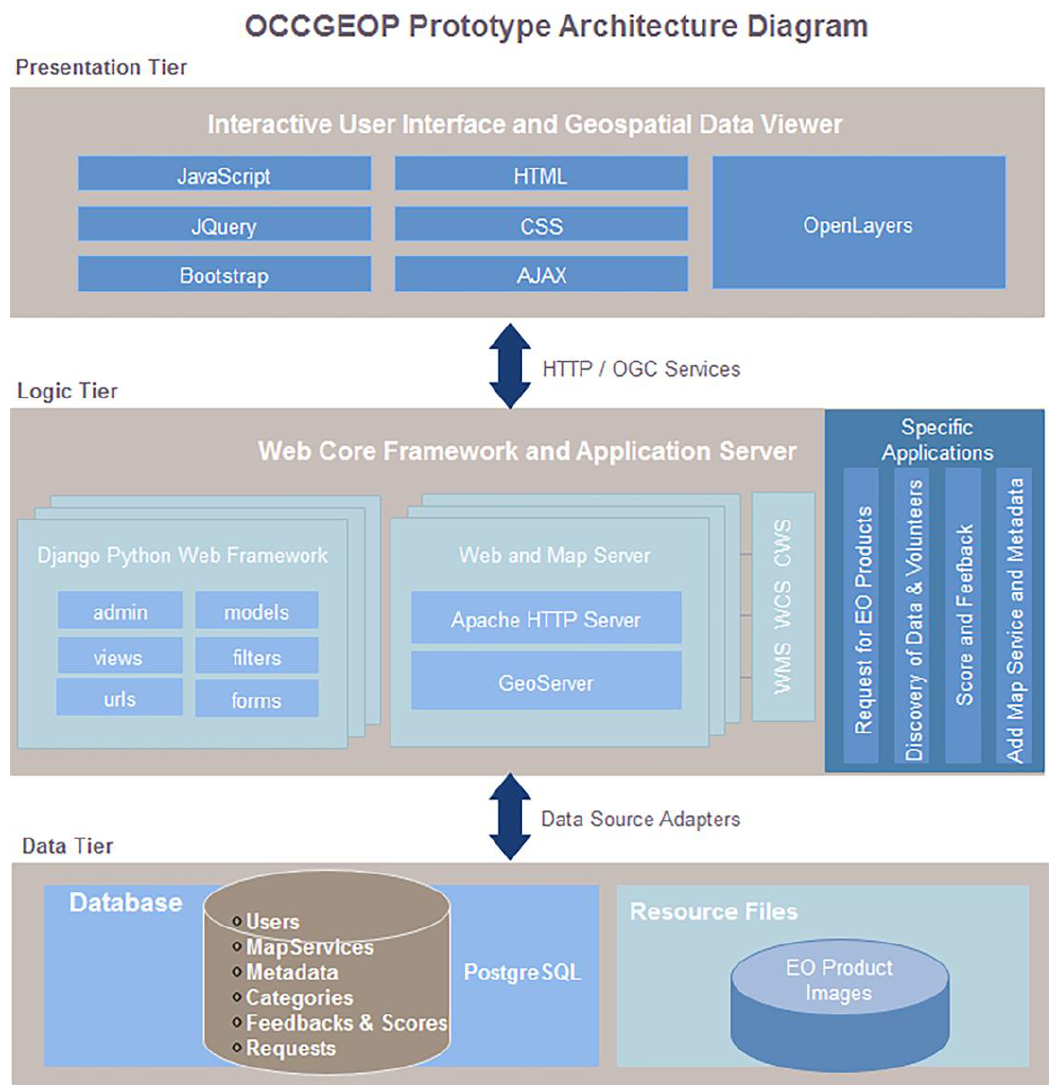
Figure 3. System architecture of OCCGEOP and the configuration of open-source technologies.